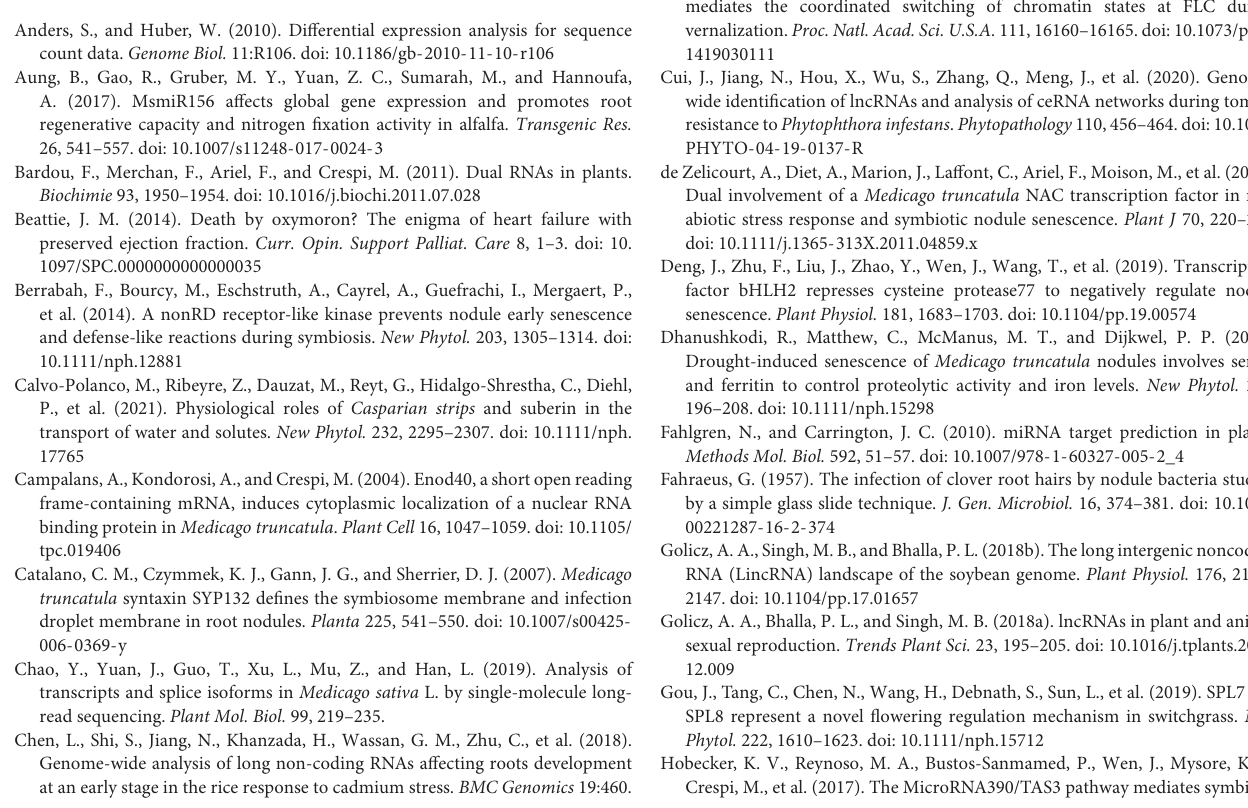
Supplementary Table 1 | Primers for qPCR.